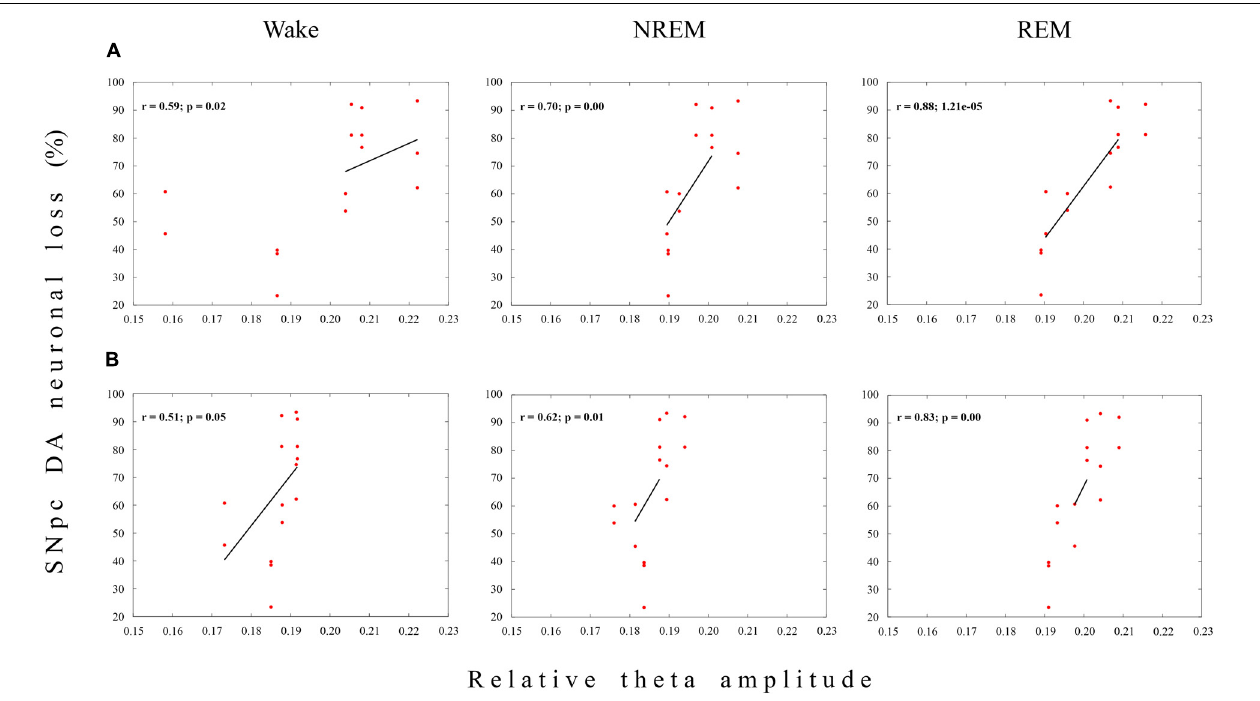
FIGURE 4 | Functional coupling between the dopaminergic neuronal loss of the substantia nigra pars compacta (SNpc) and theta amplitude during Wake, NREM and REM in the MCx. The s ignificant positive linear correlations ( r ≥ 0.51; p ≤ 0.05) between the Wake/NREM/REM relative theta amplitudes in the MCx and the dopaminergic (DA) neuronal loss throughout the overall SNpc rostro-caudal dimension at 14 (A) and 42 (B) days following the SNpc lesion caused by 12 µ g/1 µ l 6-OHDA (12 µ g/1 µ l SNpc lesion).